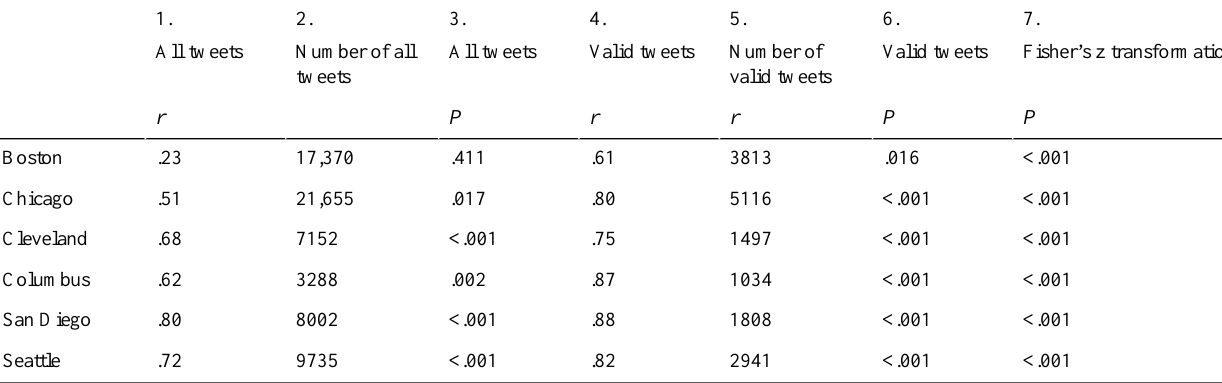
Table 5. Correlations between valid tweets and emergency department ILI a rates by city.